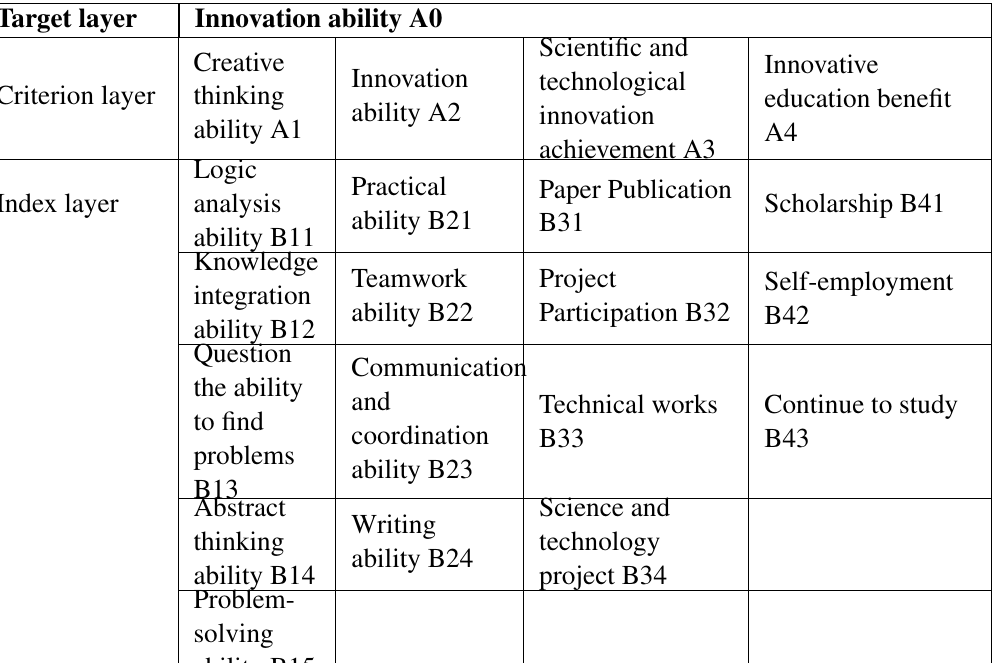
Table 1 Evaluation index